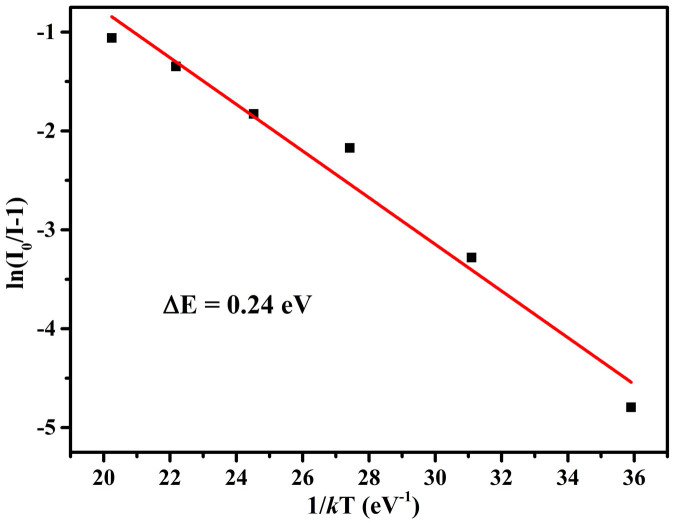
The plot of ln (I0/I) vs. 1/T of the KMg4(PO4)3:0.01Eu2+ phosphors.